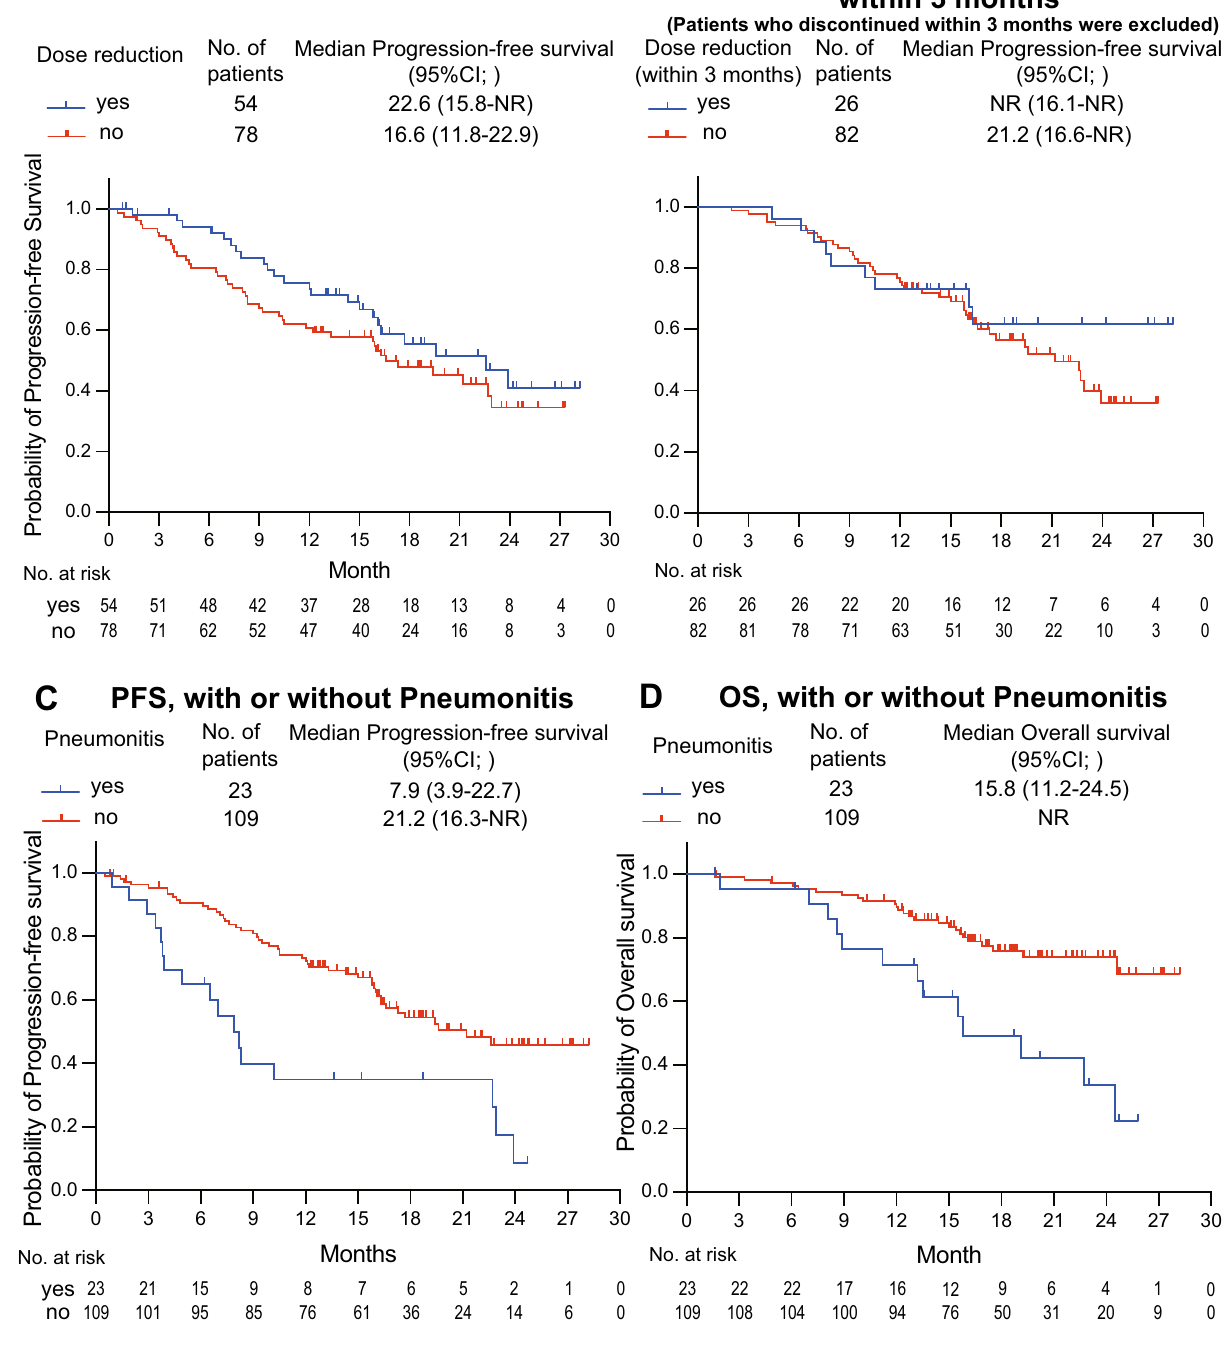
Figure 2. Kaplan–Meier curves of PFS in patients ( A ) who had dose reduction and those who remained on daily 80 mg osimertinib; ( B ) those who had dose reductions within the first 3 months and those who remained on daily 80 mg osimertinib for the first 3 months. All patients for whom treatment was discontinued within the first 3 months were excluded. ( C ) Kaplan–Meier curves of PFS in patients with or without pneumonitis. ( D ) Kaplan–Meier curves of OS in patients with or without pneumonitis. CI confidence interval, NR not reached, PFS progression-free